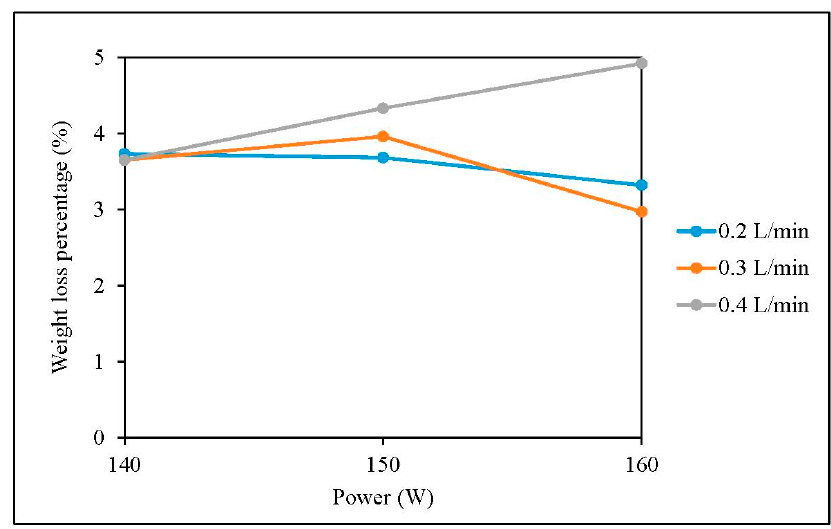
Figure 3. Weight loss percentage of single jersey fabric.